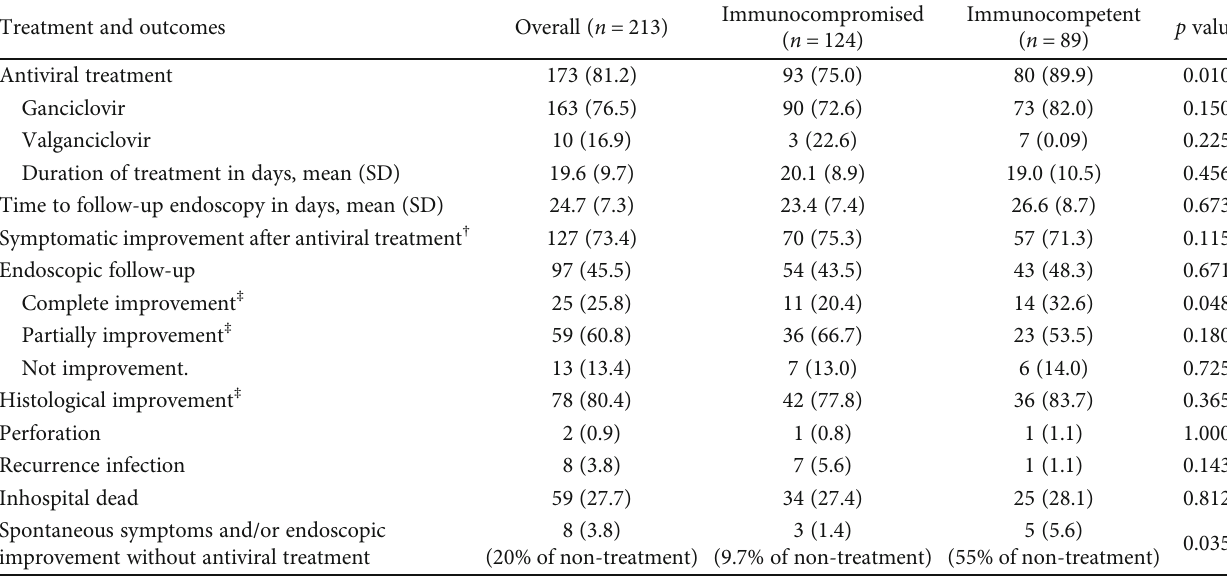
Table 3: Treatments and outcomes of TI-GI CMV disease between immunocompromised and immunocompetent patients. Treatment and outcomes